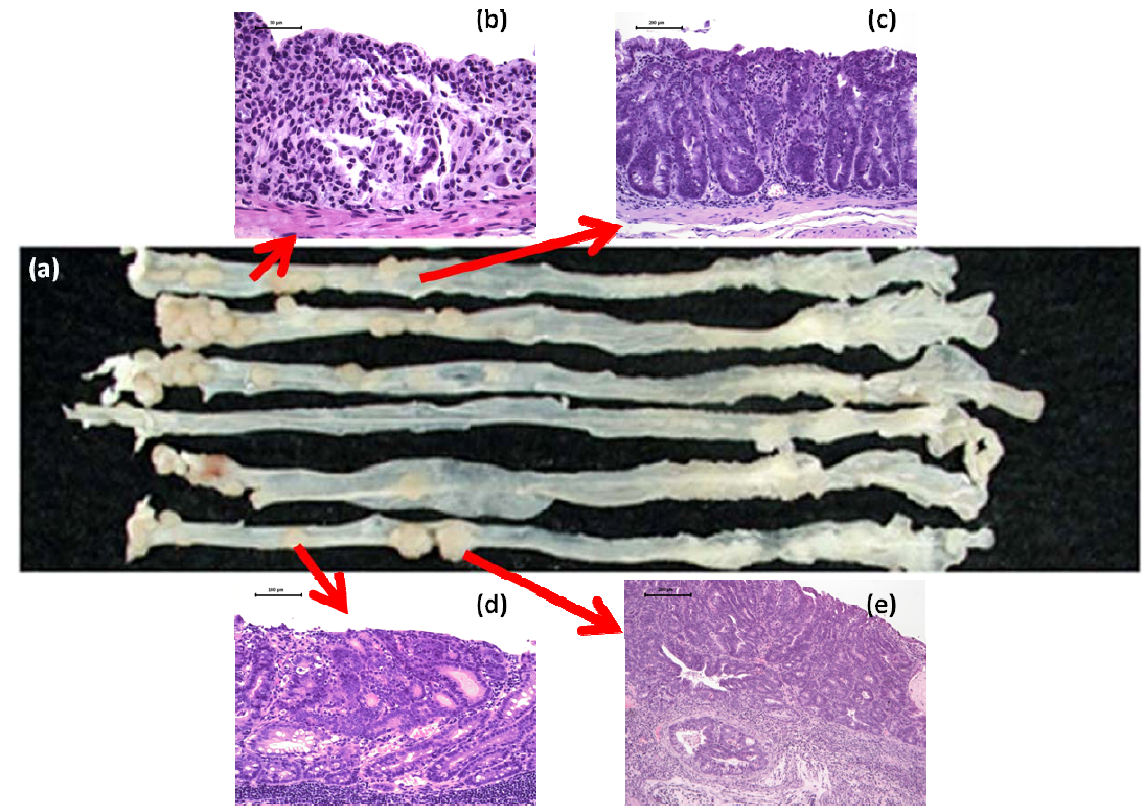
Figure 1. ( a ) Macroscopic view of colorectal tumors developed in mice that received AOM and DSS. Histopathology of ( b ) severe mucosal ulcer; ( c ) dysplastic crypts, ( d ) colonic adenoma (AD), and ( e ) adenocarcinoma (ADC) in a mouse that received AOM and